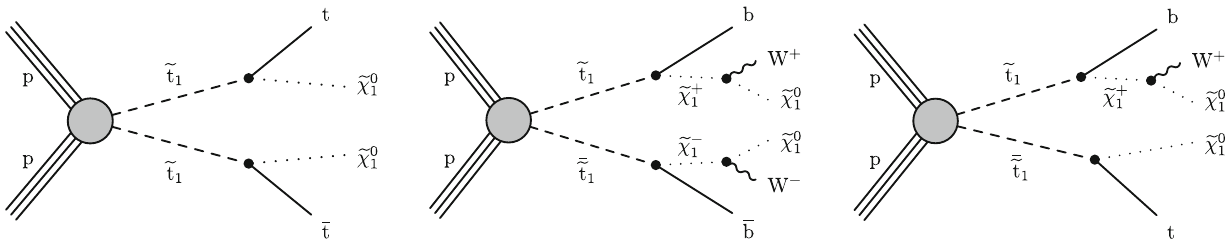
a bottom quark and a W boson (center), and with a combination of the two top squark decay scenarios (right)